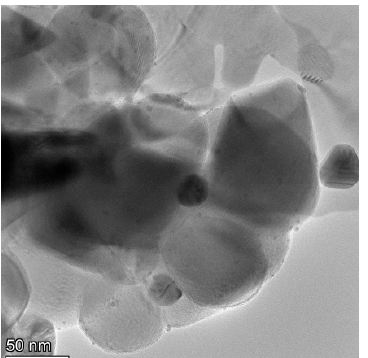
Figure 7. TEM micrographs of the 0.5%Au/3%Ag-TiO 2 catalyst at higher magnification.